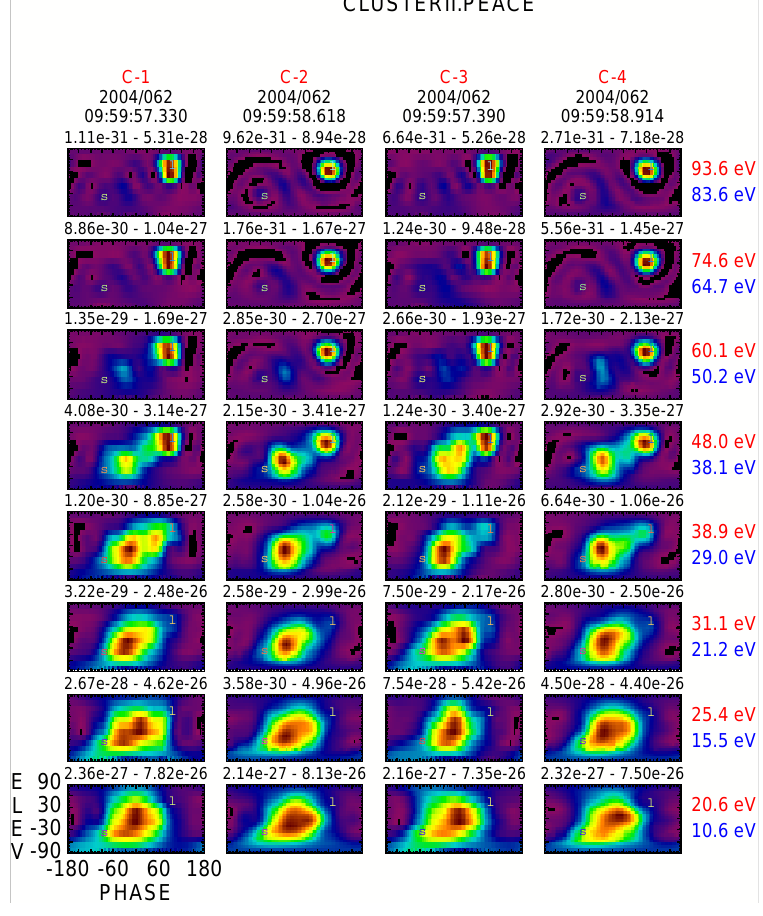
Fig. 5. PT plots of near simultaneous eVDFs as seen on all four spacecraft. There is little difference between the measurements, which are spatially separated by about